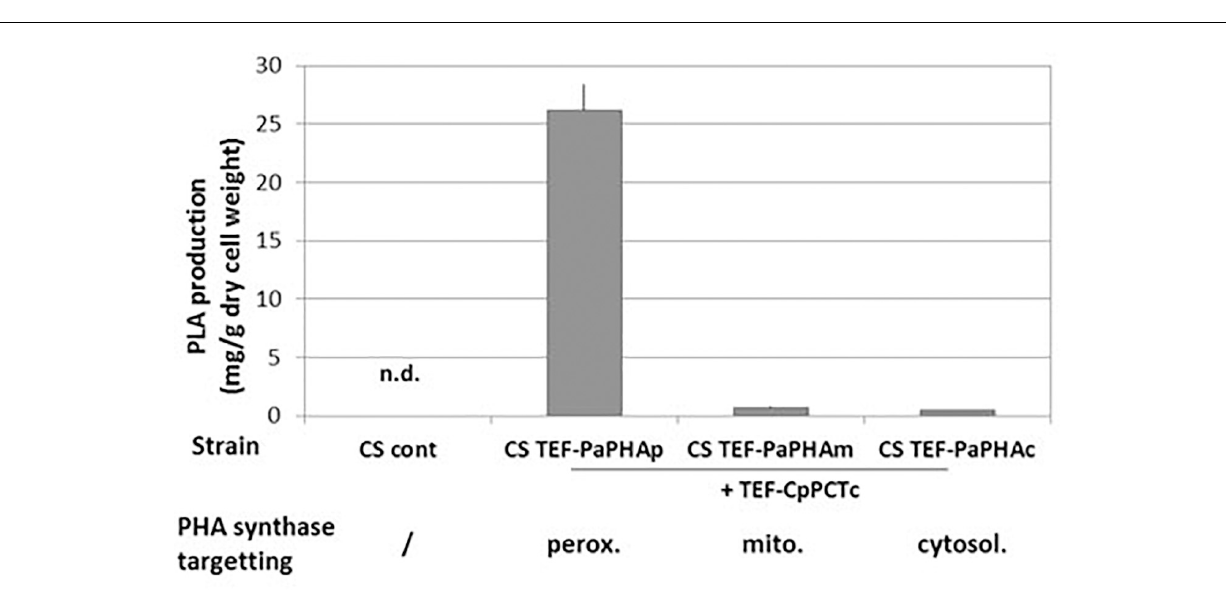
FIGURE 4 | PDLA quantification in strains expressing PHA polymerase targeted to different subcellular compartments. Strains expressing cytosolic PCT from C. propionicum and PHA synthase from P. aeruginosa targeted to indicated compartment were grown for 5 days on minimum medium containing a mixture of 10 g/L of lactic acid. After extraction, PLA quantification was measured by NMR using PLA specific peaks. N = 3 minimum independent experiments. n.d., not